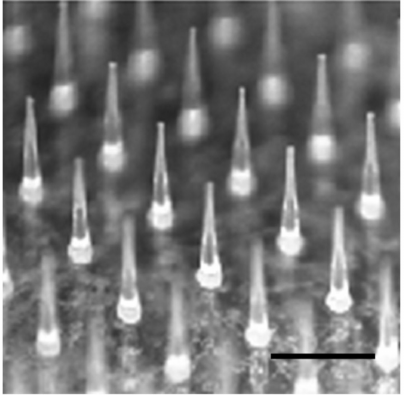
Figure 1. Typical photomicrograph of human parathyroid hormone (1-34) (PTH)-loaded microneedle arrays (MNs). Scale bar represents 800 µ m.